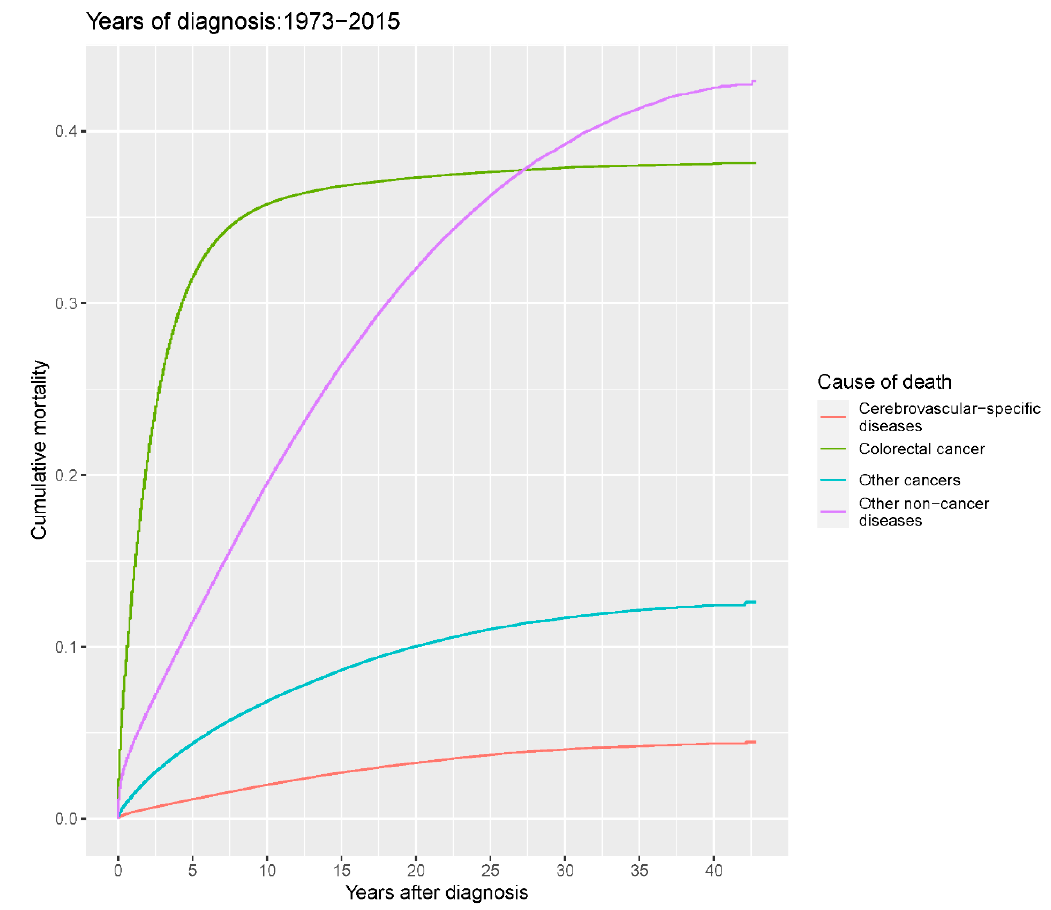
Figure 2. Cumulative cause-specific mortality among colorectal cancer patients.